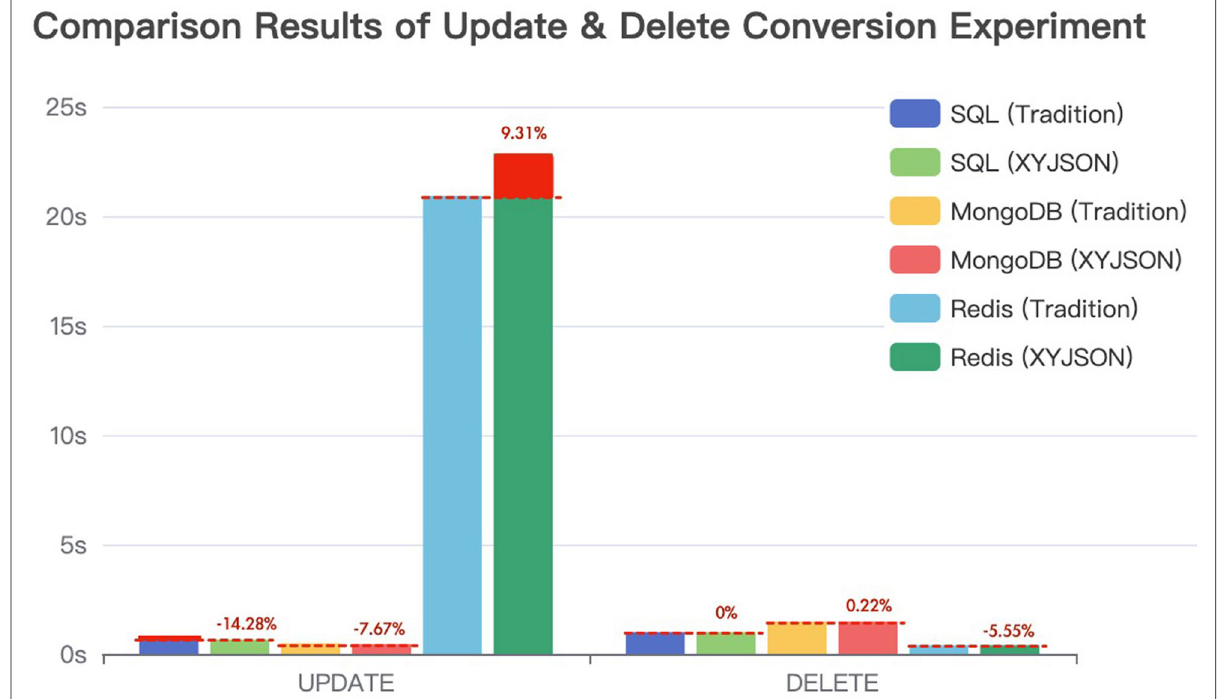
Fig. 7 Comparison results of update and delete conversion